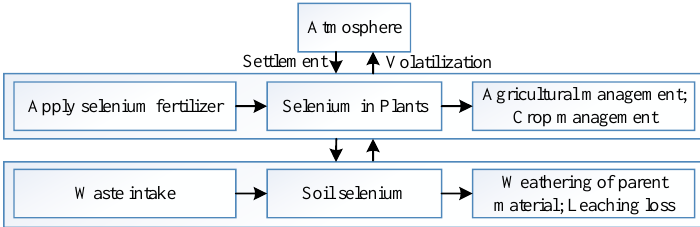
Figure 1. Selenium cycle diagram.